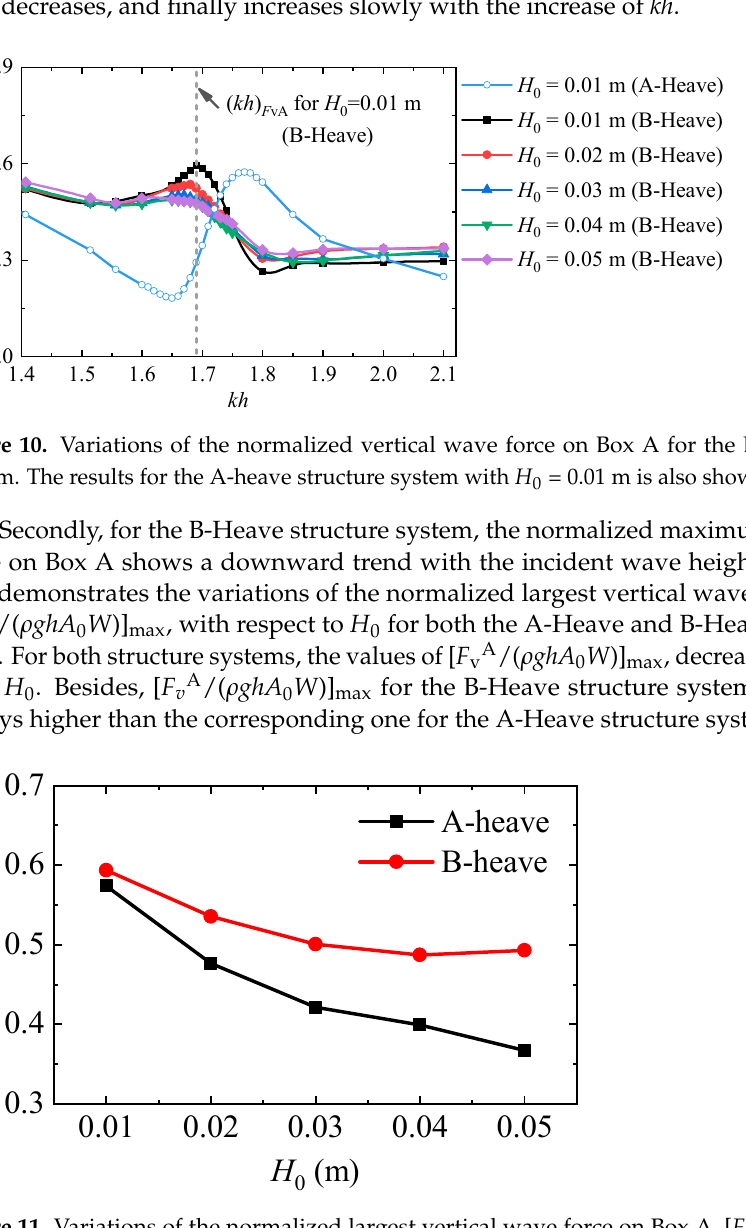
Figure 9. Variations of ( kh ) F hB against the incident wave height for both the A-Heave and the B- Heave structure systems.